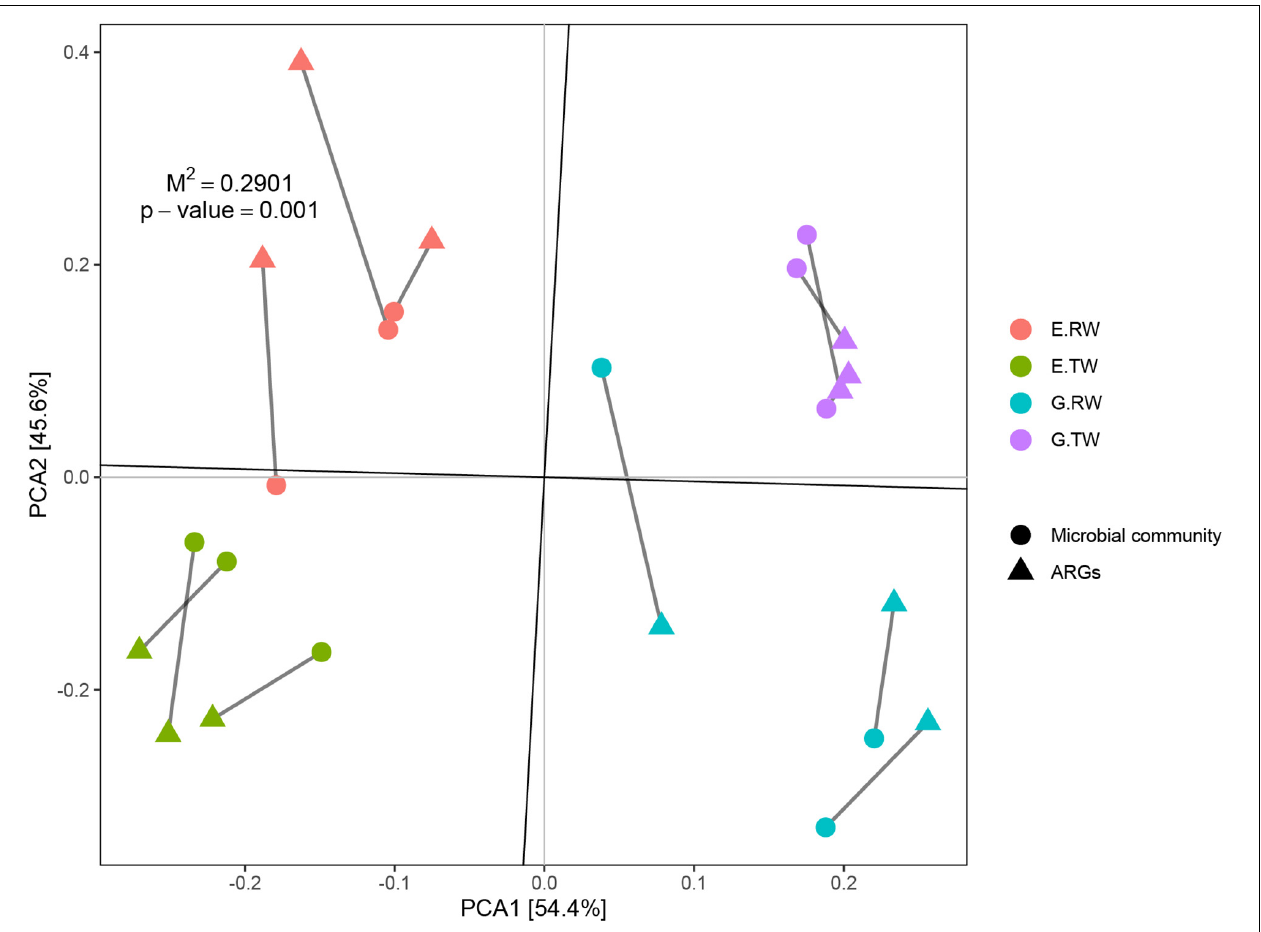
FIGURE 7 | Procrustes analyses of ARGs with microbial community based on the PCA results of ARG subtype and microbial community composition ( M 2 = 0.2901, P = 0.001, number of permutations =